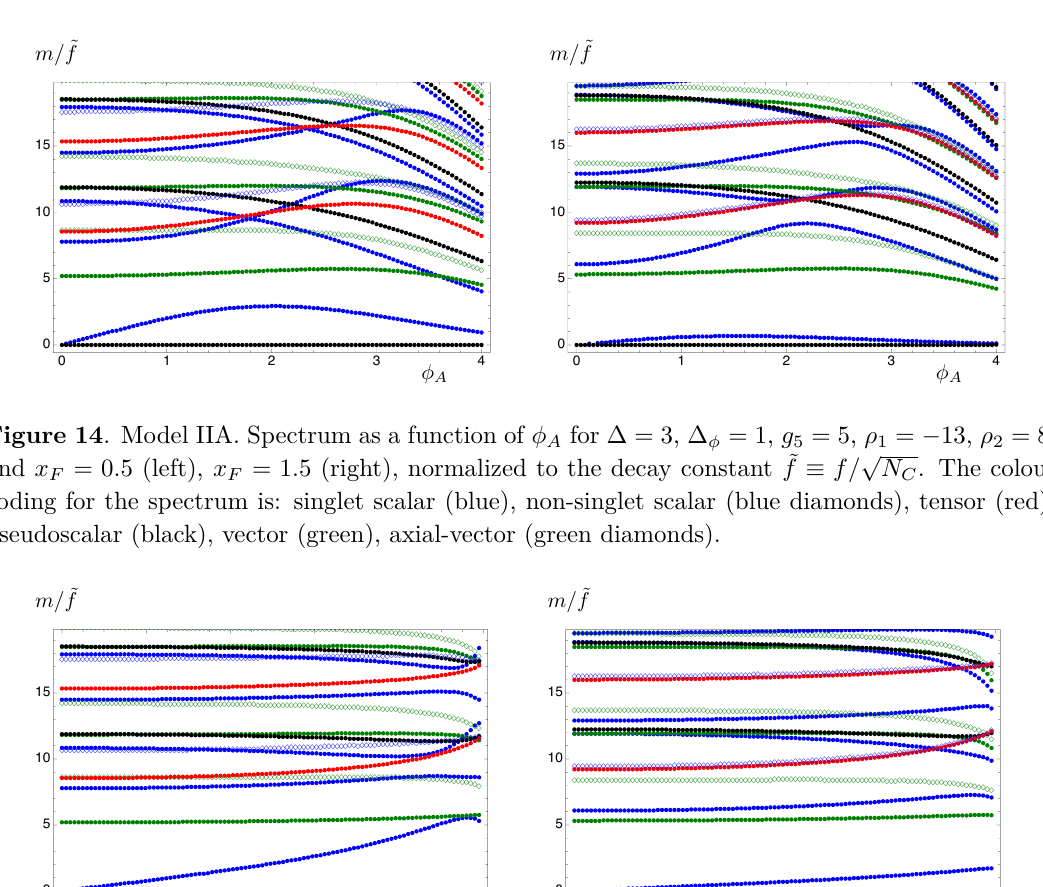
Figure 15 . Model IIB. Spectrum as a function of φ B for ∆ = 3 , ∆ φ = 1 , g 5 = 5 , ρ 1 = − 13 , ρ 2 = 8 , and x = 0 . 5 (left), x = 1 . 5 (right), normalized to the decay constant ˜ f ≡ f/ F F coding for the spectrum is: singlet scalar (blue), non-singlet scalar (blue diamonds), tensor (red), pseudoscalar (black), vector (green), axial-vector (green